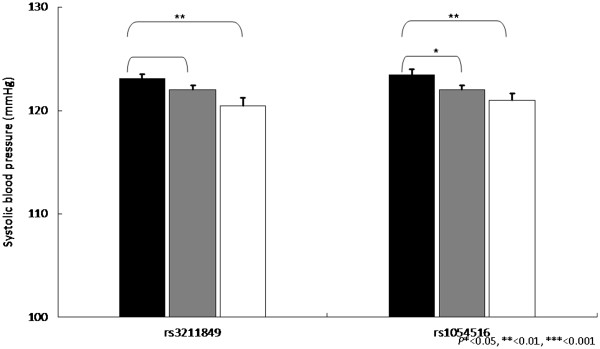
Impact of CD36 gene on systolic blood pressure (mmHg ± SE) from pairwise genotype comparisons. Adjusted mean systolic blood pressure for non-carriers (black bars), for heterozygous (gray bars) and subjects homozygous for the minor allele (white bars). Sample sizes (n for non-carriers, heterozygous, and homozygous subjects for SNP (rs3211849), n = 621, 664, 207, and for SNP (rs1054516), n = 466, 720, 308, Resulting co-dominant P-values as 0.009 and 0.007.